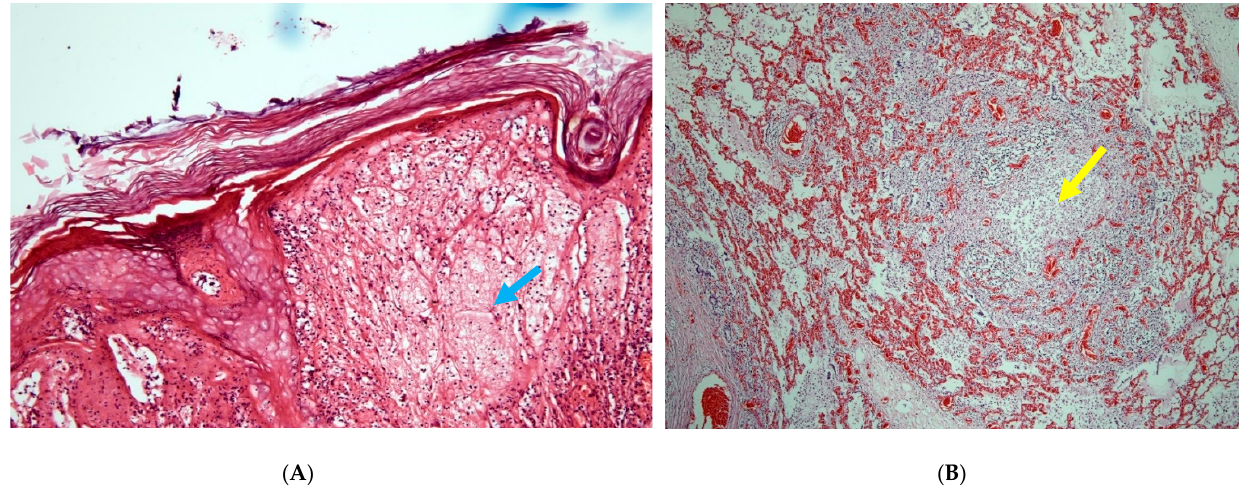
Figure 2. ( A ) Skin with focal marked cytoplasmic swelling and ballooning vacuolation (blue arrow) of keratinocytes in the stratum spinosum of the epidermis. HE, 120 × magnification (D1804/20). ( B ) Lung with consolidated focus consisting of alveoles containing a mixture of infiltrating mononuclear cells (yellow arrow) as well as cytoplasmic and nuclear debris (HE, 120 × magnification, D2053/20).